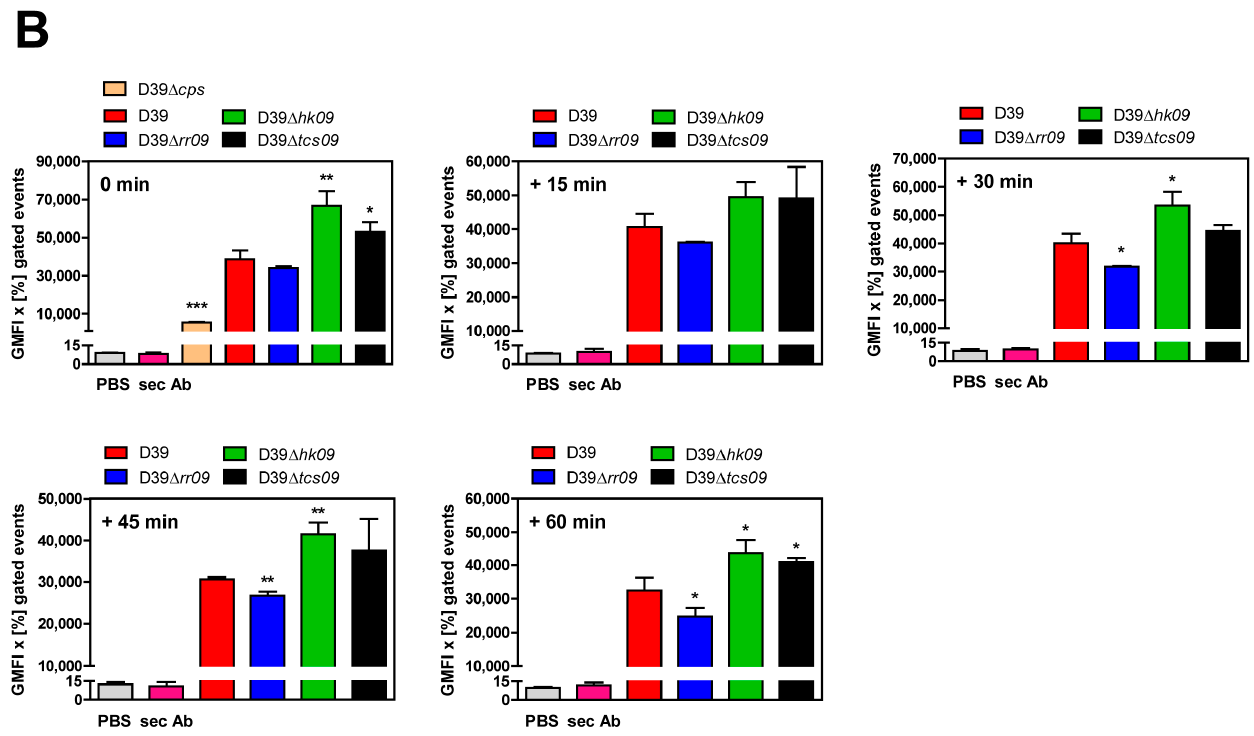
Figure 5. Abundance of surface exposed capsule in S. pneumoniae D39 and its isogenic tcs09 -mutants measured via flow cytometry. The capsule expression of pneumococci was investigated via flow cytometry over a period of time of 60 min. For the analysis, 2 × 10 8 bacteria of D39 ∆ cps , the D39 wild-type, and its isogenic ∆ rr09 -, ∆ hk09 -, and ∆ tcs09 -mutants cultured in CDM with glucose were used. To analyze capsule detachment, pneumococci were resuspended in PBS over 15–60 min before capsule detection. ( A ) An increase of the fluorescence intensity (FL-1 H channel) in the histograms shows a higher capsule expression of the pneumococci. ( B ) Shown are the calculated geometric mean fluorescence intensities (GMFI) x [%] gated events. Results are presented as the mean ± SD for three independent experiments. An independent student’s t-test proved a significance with p -values * < 0.05, ** < 0.01, and *** < 0.001 relative to the parental pneumococcal strain